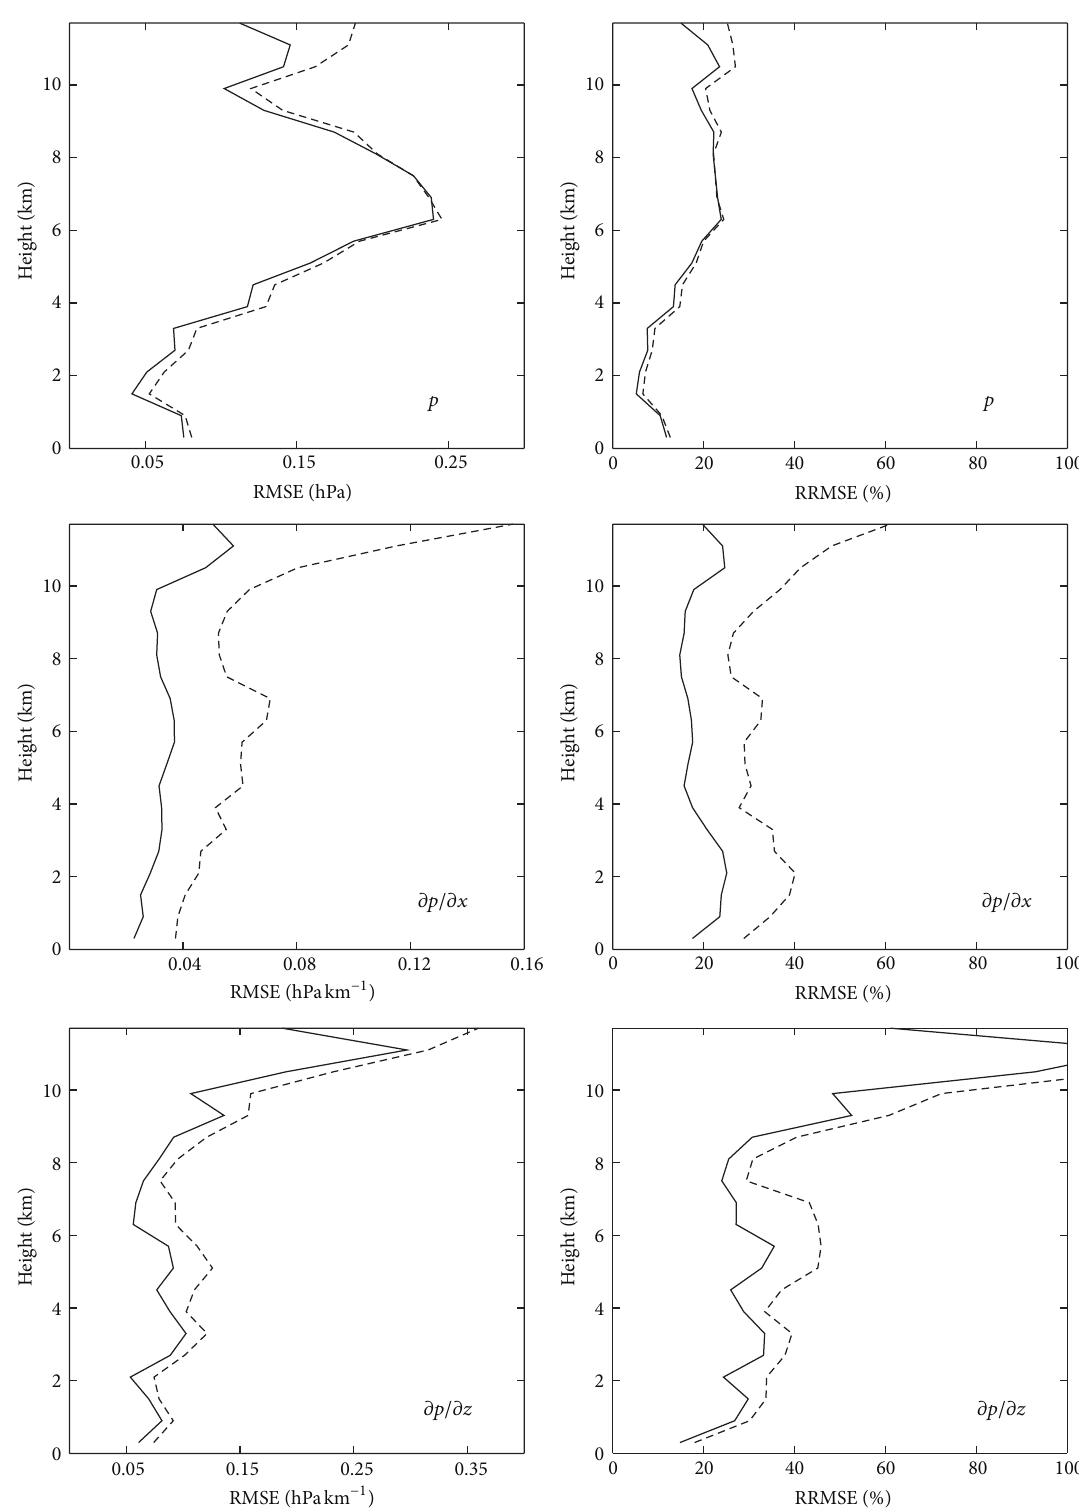
/𝜕𝑥 (middle row), and 𝜕𝑝 /𝜕𝑧 (bottom (top row), 𝜕𝑝 final final final